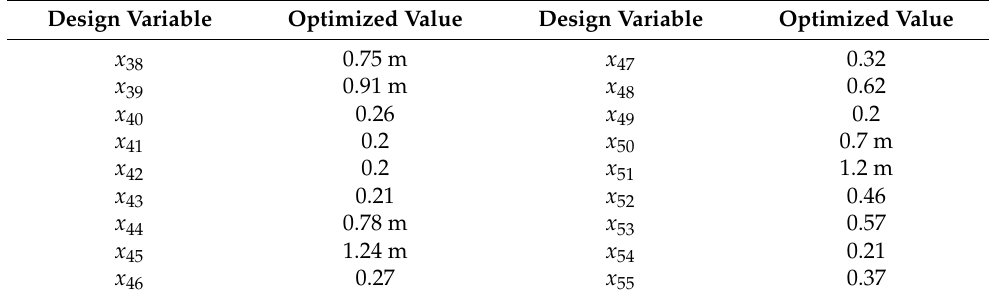
Table 5 gives the optimal solution of the structural parameters of the machine